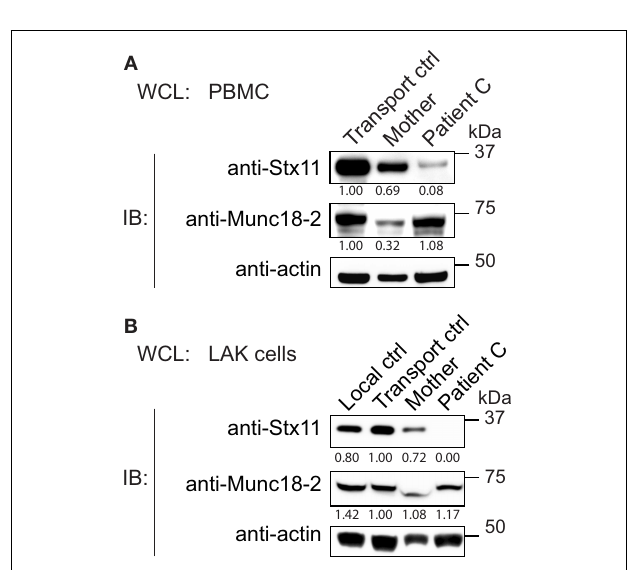
FIGURE 3 | Low expression of syntaxin-11 L58P in patient lymphocytes .Whole cell lysates (WCL) prepared from (A) PBMC or (B) LAK cells from Stx11 L58P patient C and controls, as indicated, were analyzed byWestern blotting for Stx11 and Munc18-2. β -actin was probed as a loading control. Densitometry values normalized to β -actin for each individual are